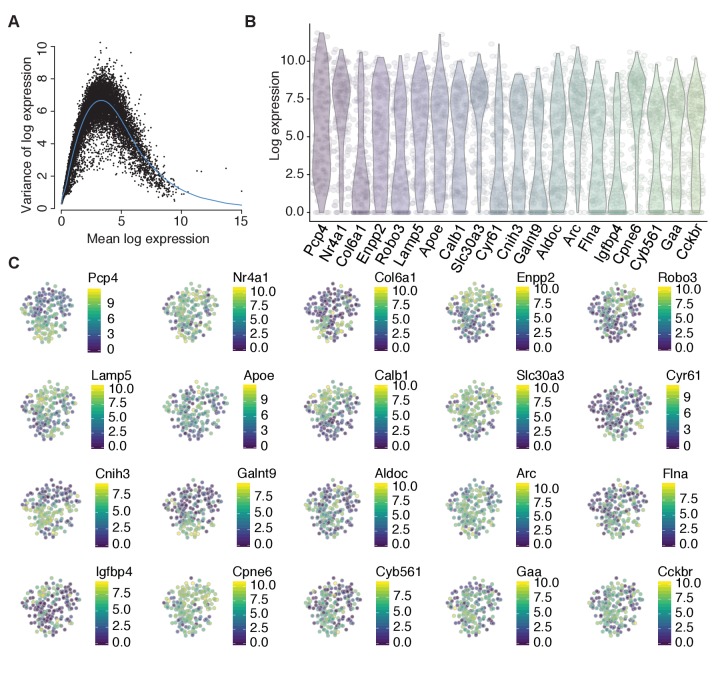
Expression of top highly variable genes, related to Figure 2F–H.(A) Variance of normalized log-transformed expression for each gene plotted against the mean log-transformed expression. (B) Violin plots of log-transformed expression values for the top twenty highly variable genes across all cells. (C) T-distributed stochastic neighbor embedding (t-SNE) was performed using the top highly variable and correlated genes (n = 91). Plots are colored by log-transformed expression values for the top twenty highly variable genes.